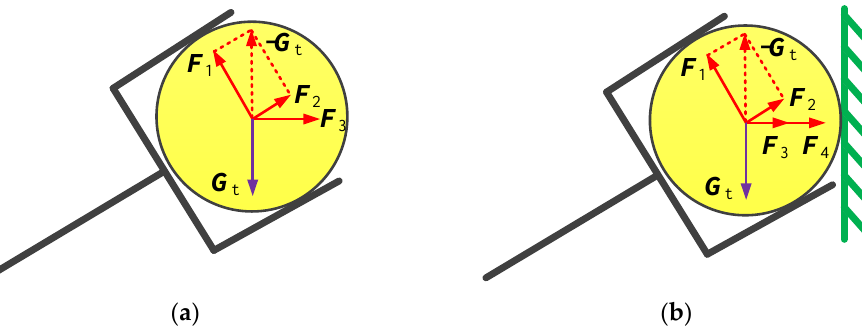
Figure 2. Distribution of the generalized terminal force between the end-effector and the workpiece at the center of mass of the workpiece; ( a ) the workpiece is in free motion ( b ) the workpiece is in contact with the environment.